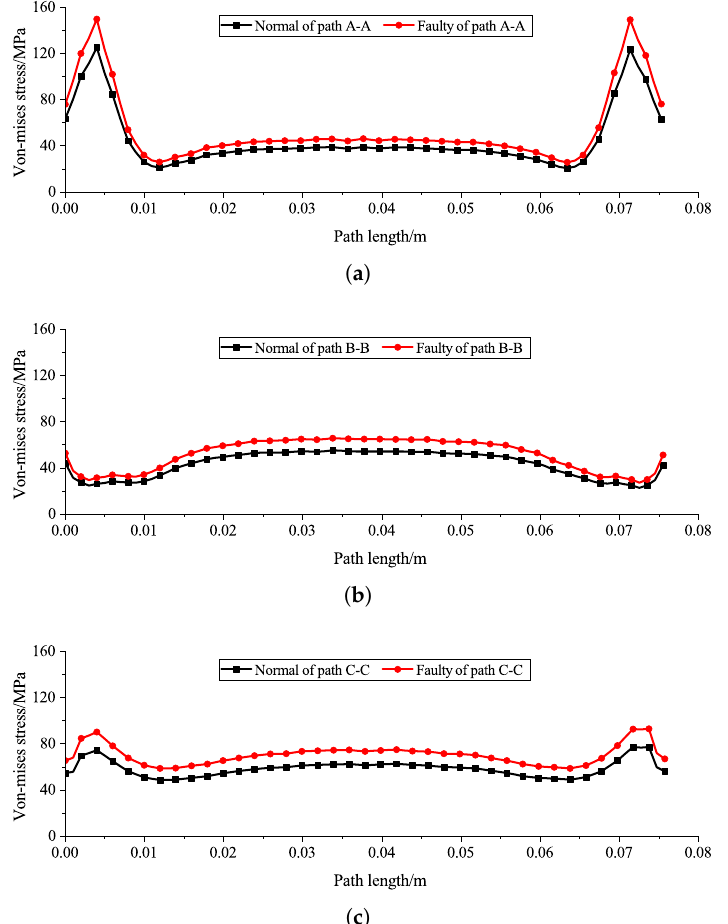
Figure 17. Thermal stress distribution along the paths of normal and faulty barss. ( a ) Path A-A. ( b ) Path B-B. ( c ) Path